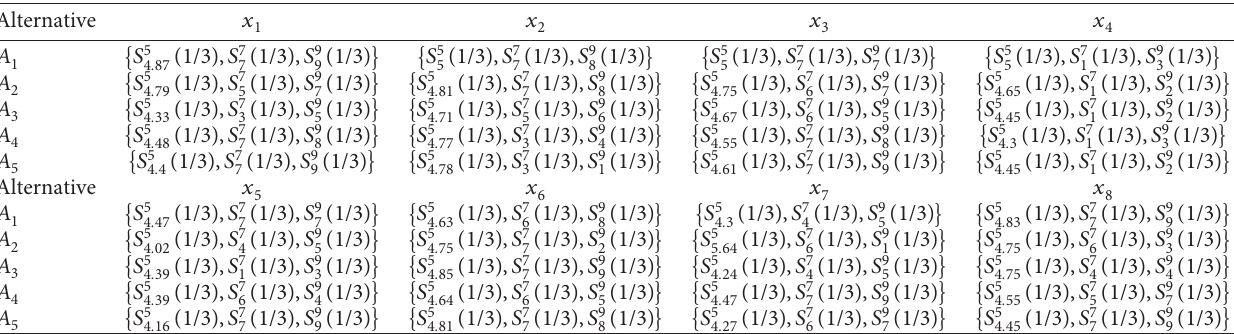
Table 5: The probabilistic linguistic evaluation matrix.